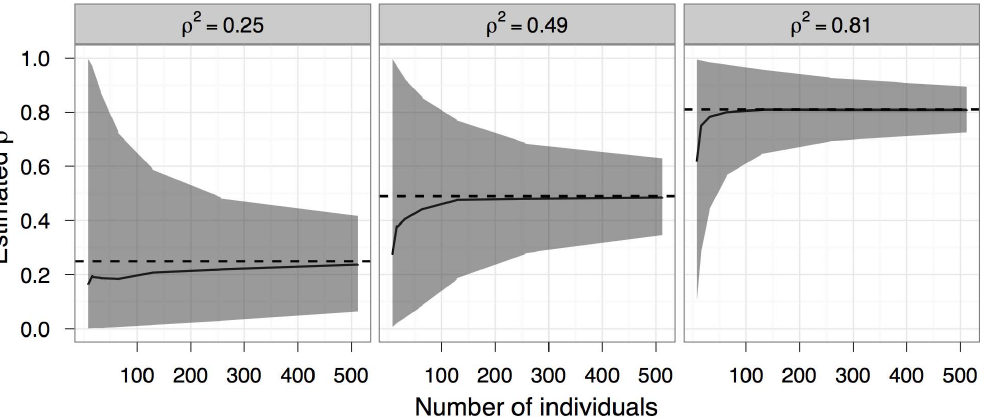
Figure 2. Estimates of growth autocorrelation r 2 . Estimates of r 2 (solid lines), true values of r 2 (dashed horizontal lines) and 95% confidence intervals (gray ribbons), averaged over 1000 replicates for each parameter combination. Number of time points n t =16.